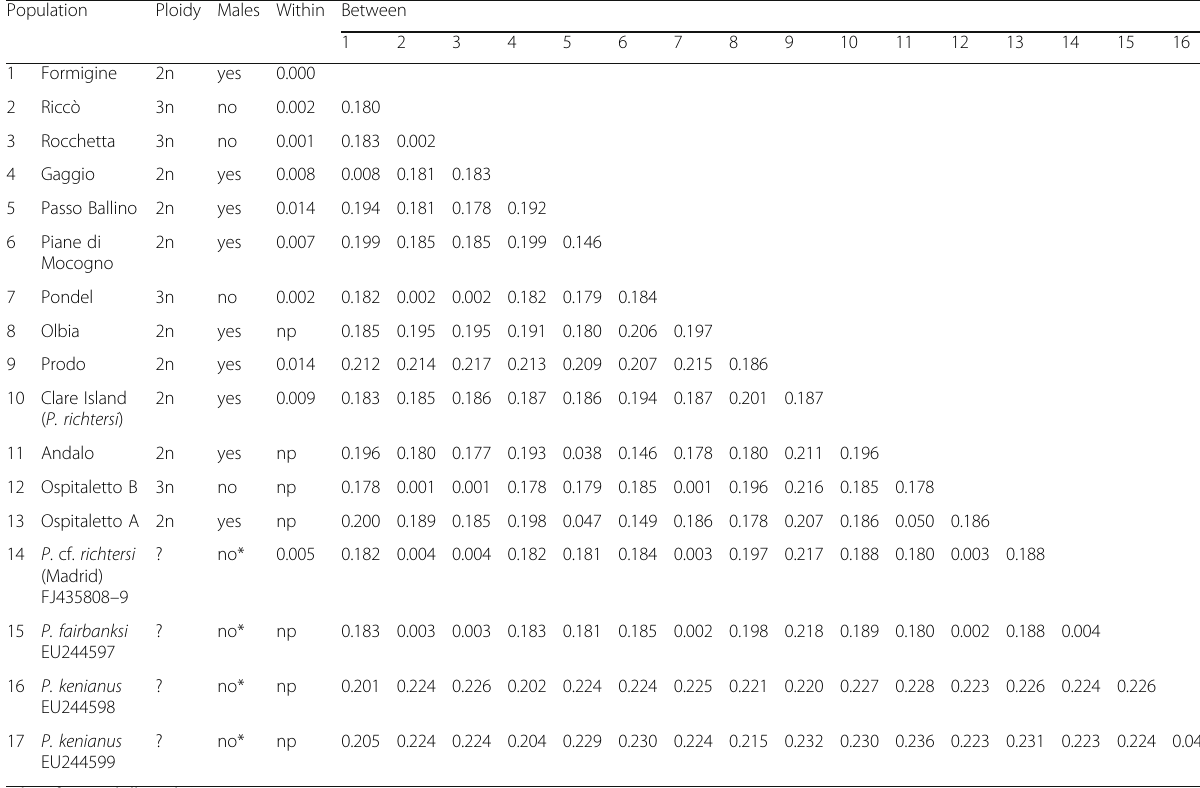
Table 3 Mean genetic distances (p-distance) computed among and within populations. All new haplotypes and those available in GenBank have been considered in the analysis, which was carried out on a 606 bp dataset. np, not possible Population Ploidy Males Within